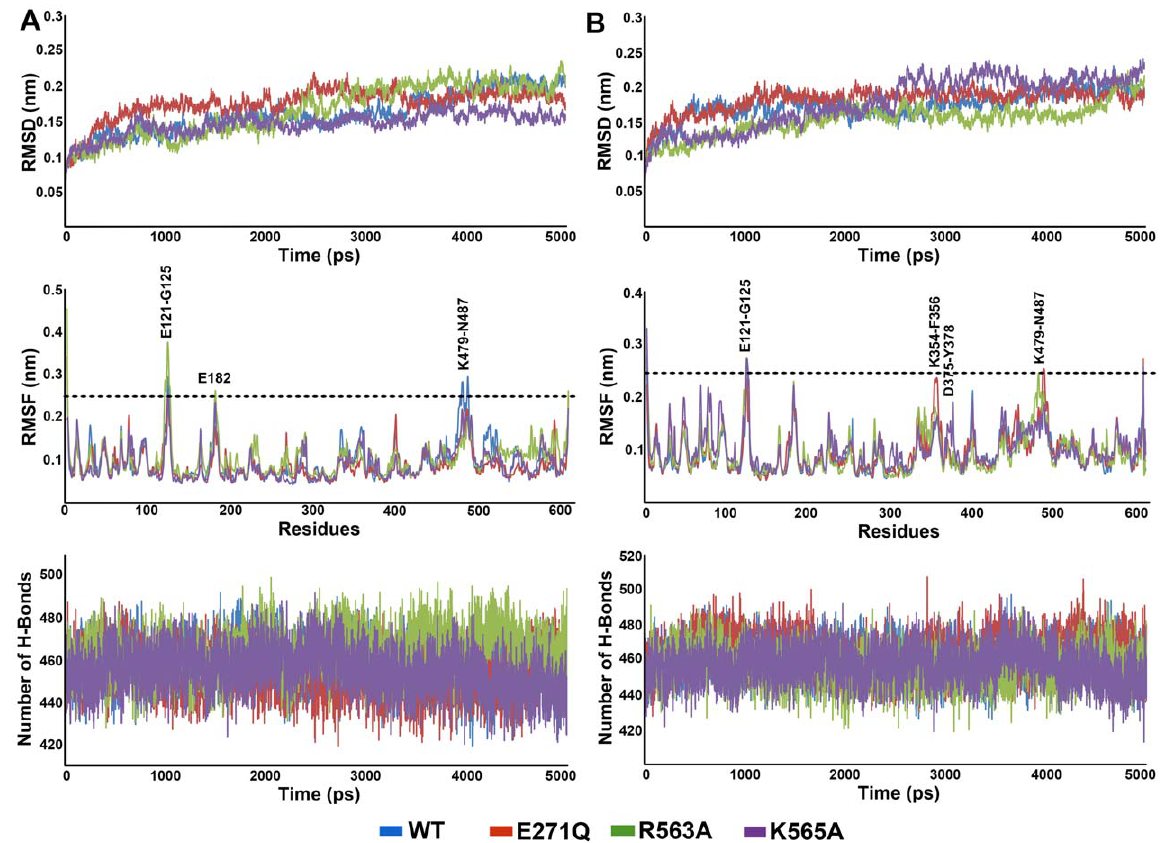
Figure 4. Basic analyses to investigate the overall of behavior of the systems during the MD simulations. The RMSD, RMSF, and number of intramolecular hydrogen bonds are shown for (A) L-LTA4 (B) L-RAR systems.